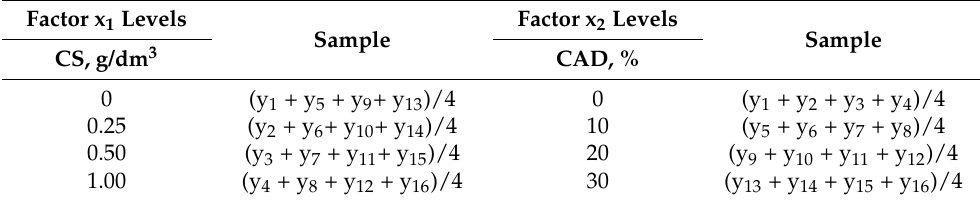
Table 3. Experiment factors levels and their corresponding samples. Factor x 1 Levels